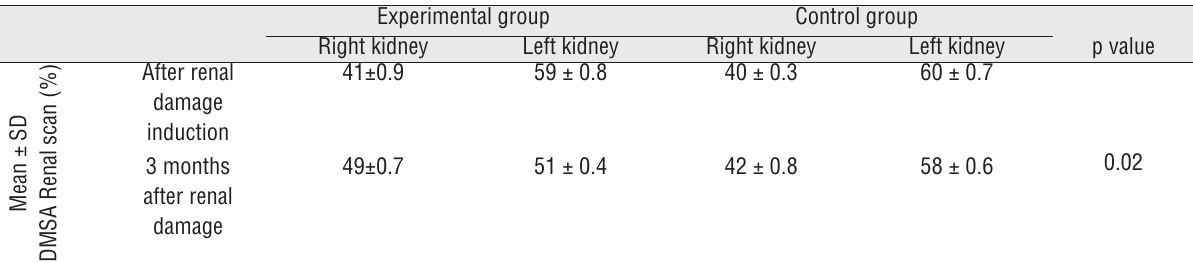
Table 1 - comparing the renal function after renal damage induction and 3 months postoperatively in pregnant (experimental group) and non-pregnant (control group)